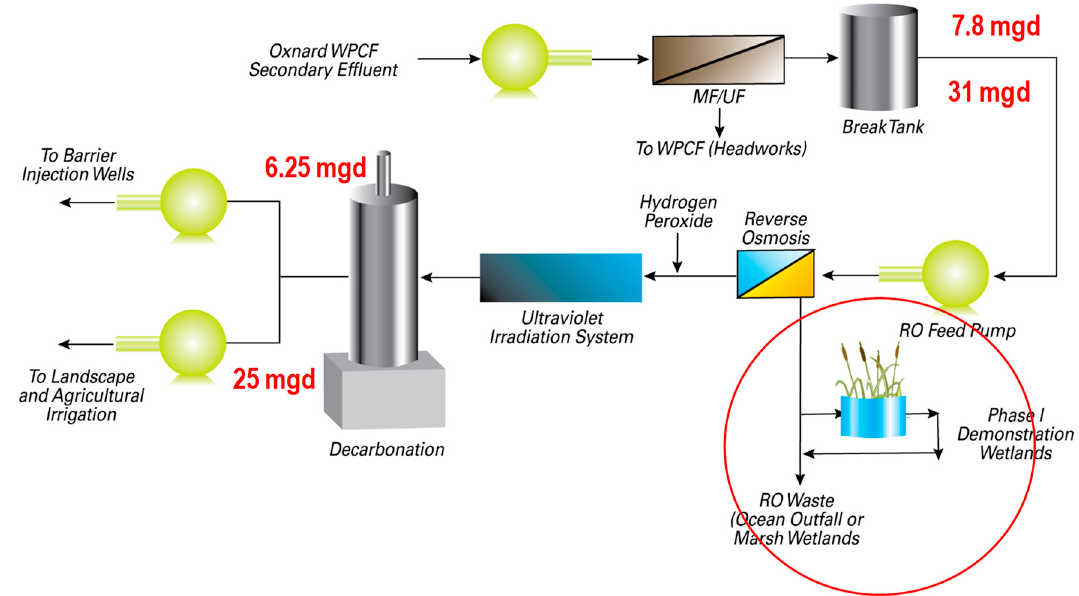
Figure 3. Oxnard Advanced Water Purification Facility (AWPF) Process Schematic. The red circle shows the pilot constructed wetland receiving ROC .